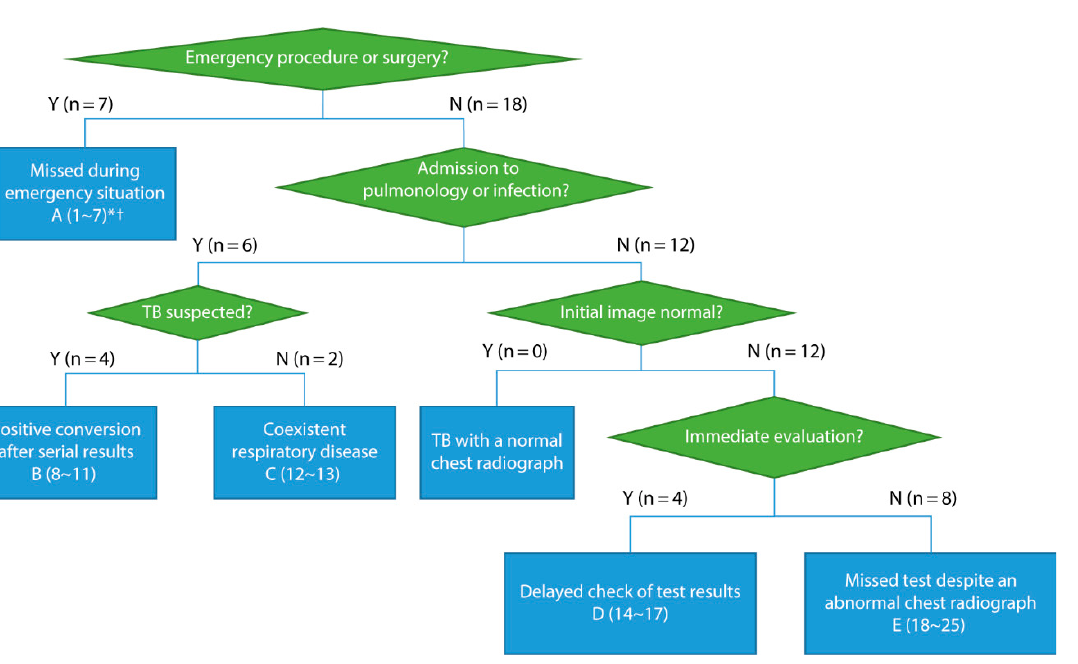
Figure 1. Diagnostic flow of index patients. * Category (index number). TB, tuberculosis. † One patient in category A was admitted to the pulmonology department.